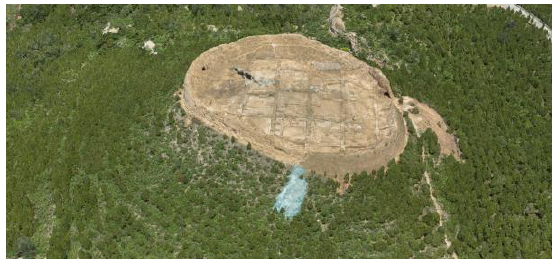
Figure 5. Site area and surrounding environment model